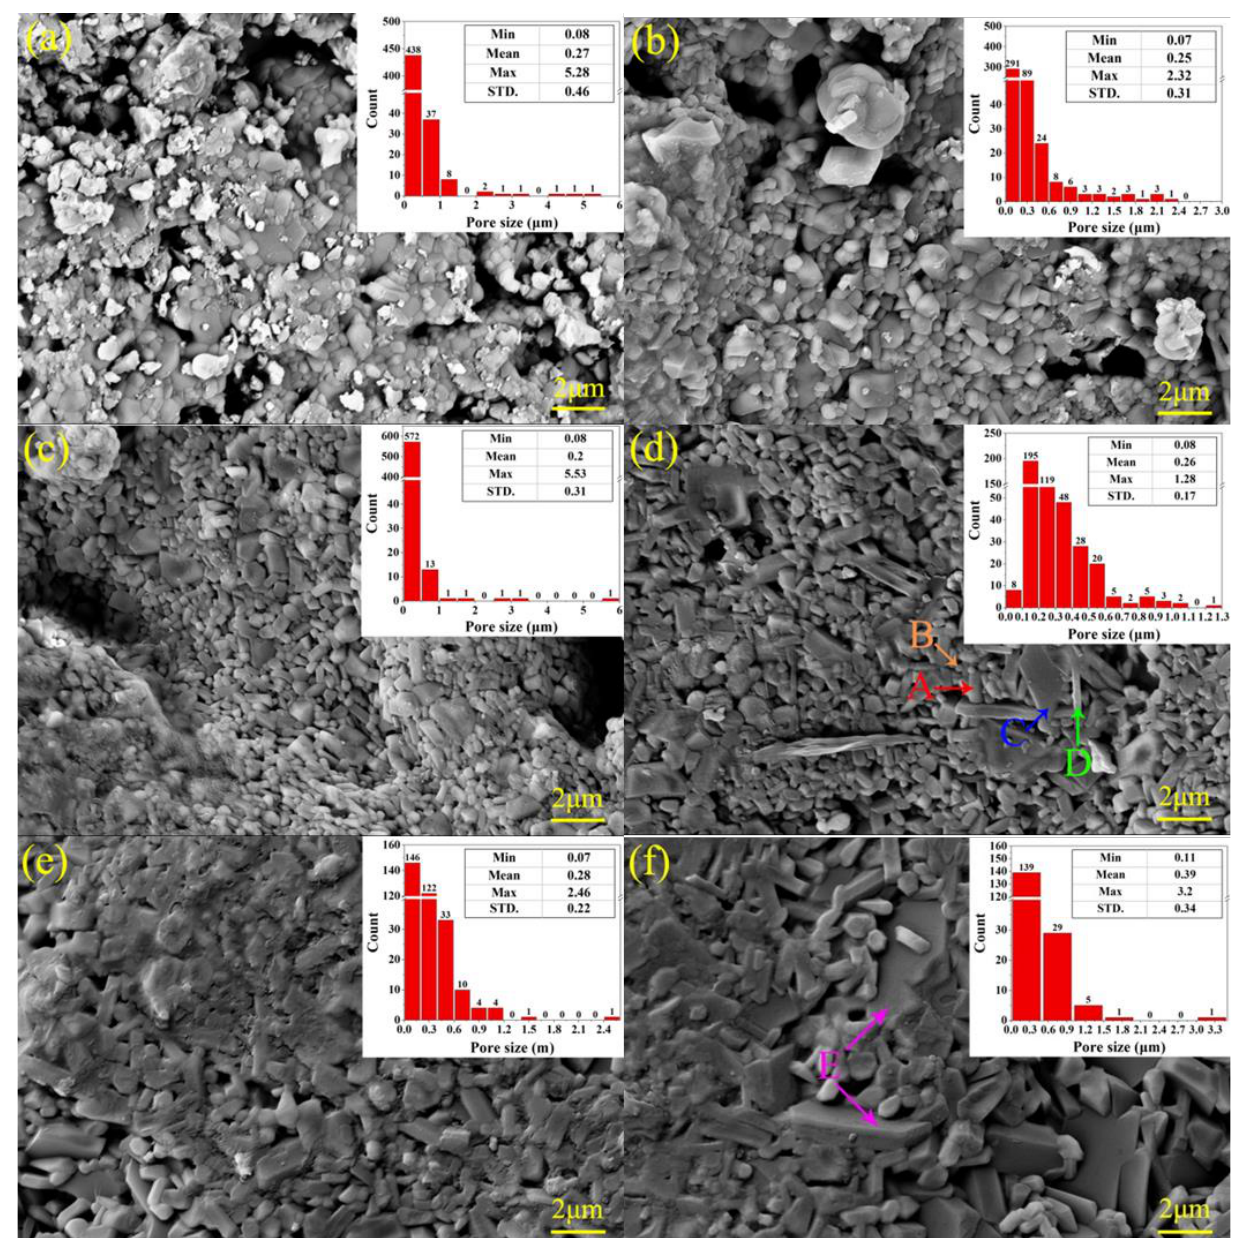
Figure 5. SEM photos of the ceramic samples. ( a ) IC-00 sample, ( b ) IC-10 sample, ( c ) IC-20 sample, ( d ) IC-30 sample, ( e ) IC-40 sample, and ( f ) IC-50 sample. A: short-columnar, B: granular, C: flake, D: needle-like, and E: plate-like.